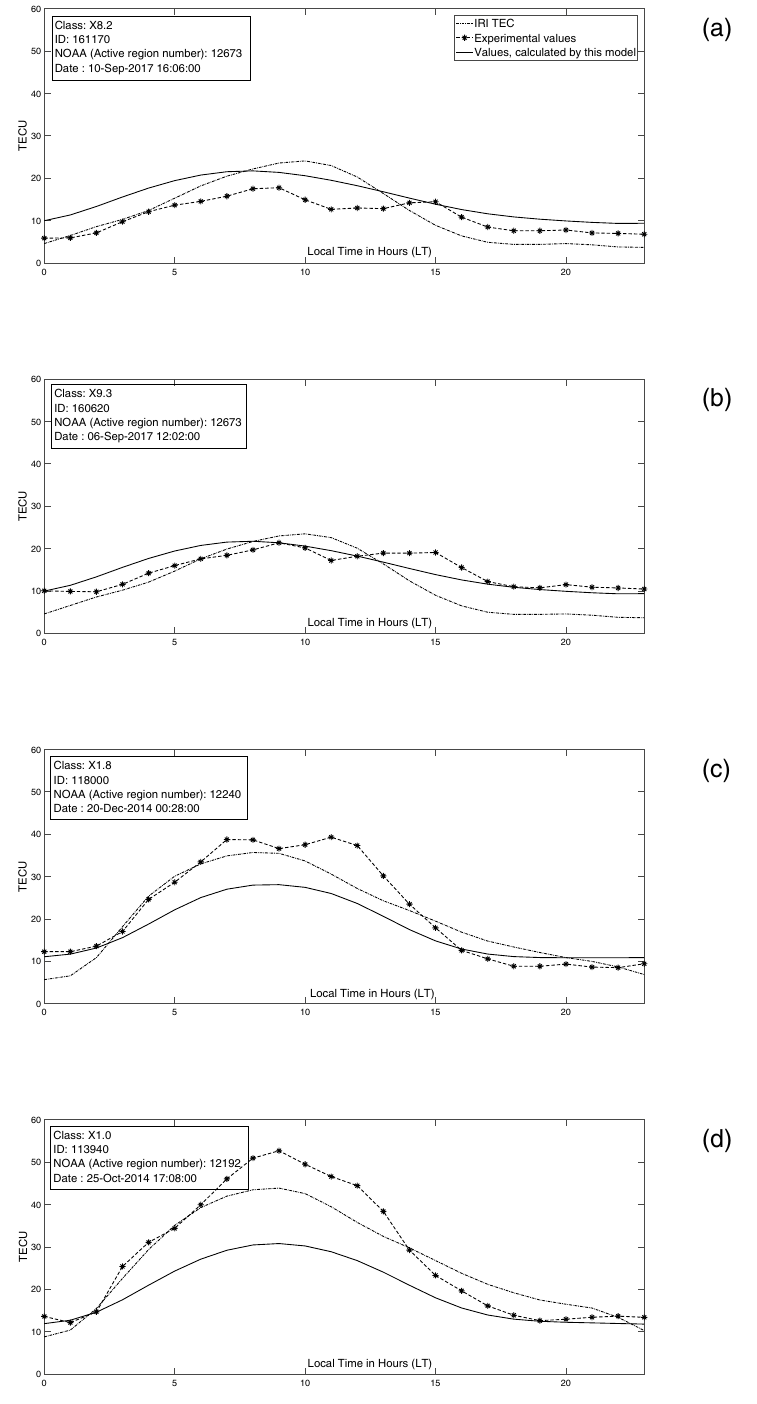
Figure 16. Daily variation of TECU for few different